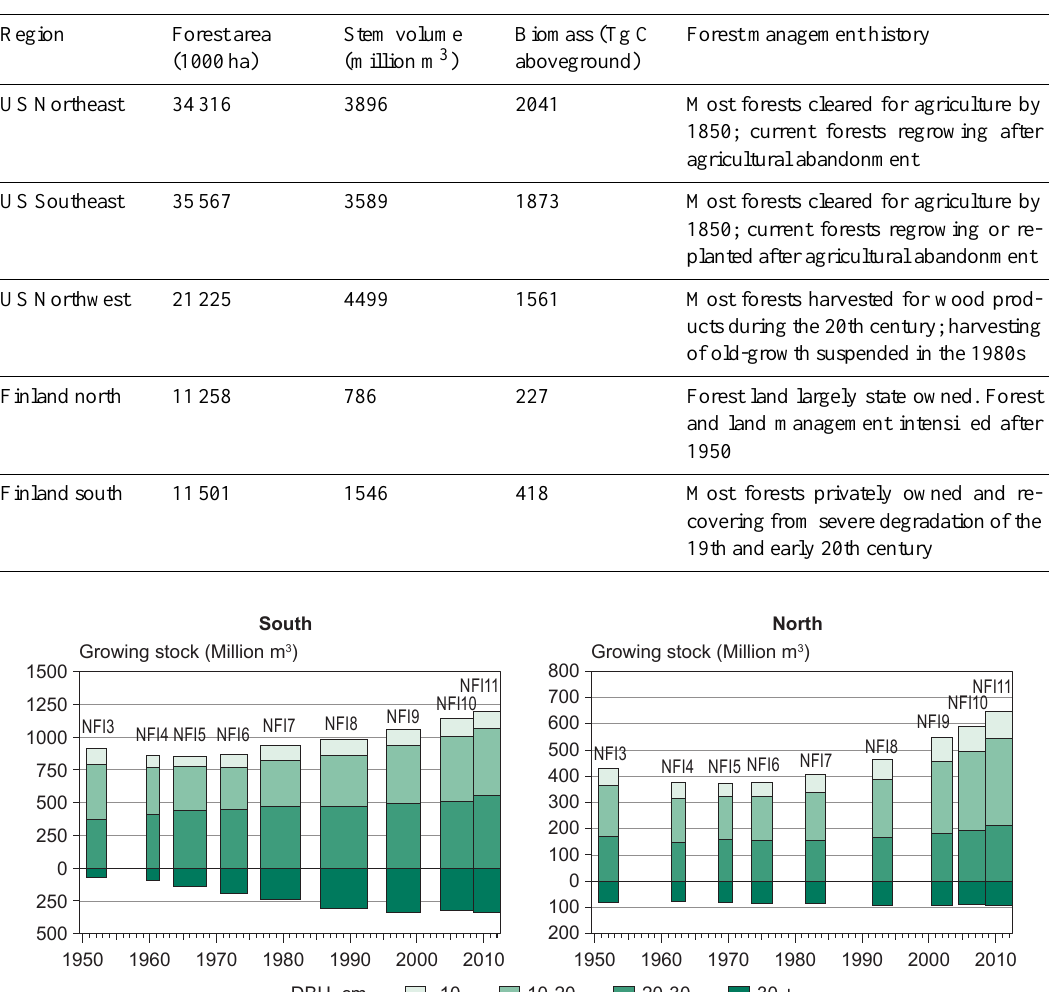
Table 1. Statistics and forest management history of the sub regions addressed in this research. Forest area estimates for Finland include poorly productive land called scrubland (Smith et al., 2009; Ylitalo, 2013).